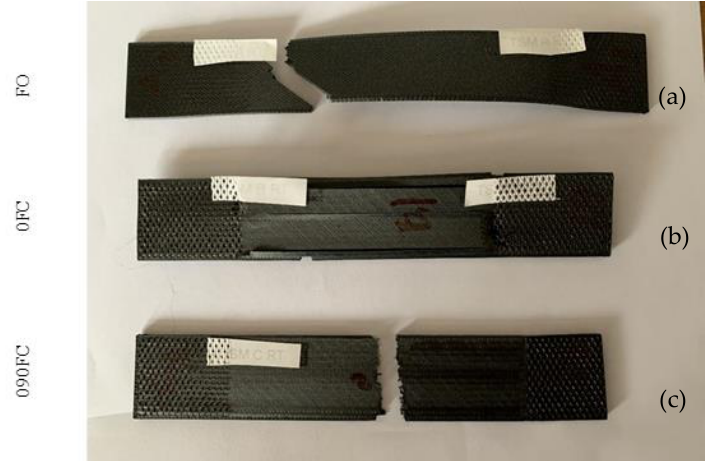
Figure 10. SEM analysis of the fracture surface: ( a ) FO; ( b ) 0FC; and ( c ) 090FC.